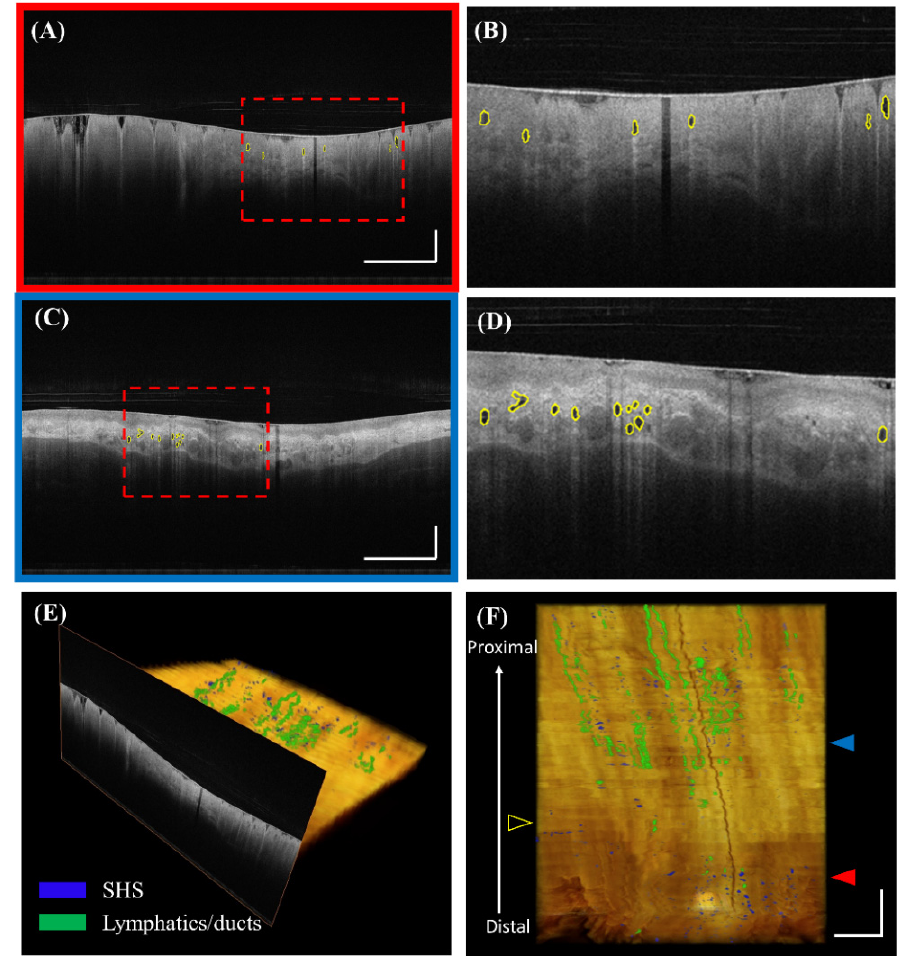
Figure 4. Visualization of automatically detected SHSs. ( A ) Volumetric laser endomicroscopy (VLE) image with automatically detected SHSs under the BE region in polar coordinates. ( B ) Corresponding zoomed-in view. ( C ) Automatically detected SHSs under the squamous region. ( D ) Corresponding zoomed-in view. ( E ) and ( F ) 3D visualization of SHSs (blue) and lymphatics/ducts (green). The registration line on the balloon is also visible as a dark band traversing the entire pullback. The red and blue solid arrows indicate the cross-sectional position of ( A ) and ( C ), respectively. The yellow hollow arrow indicates the maximum extent of BE. Scale bars: 1 mm.